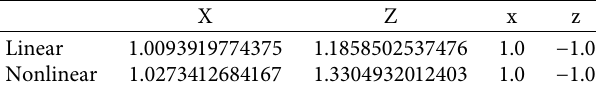
Table 1: Solution of the initially unknown and known confgu- ration of the 3-bar structure in Figure 5.